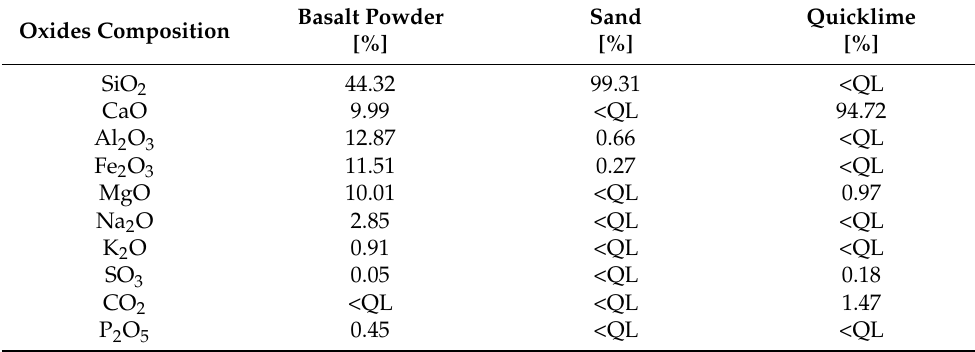
Table 1. Chemical composition of basalt powder, sand and